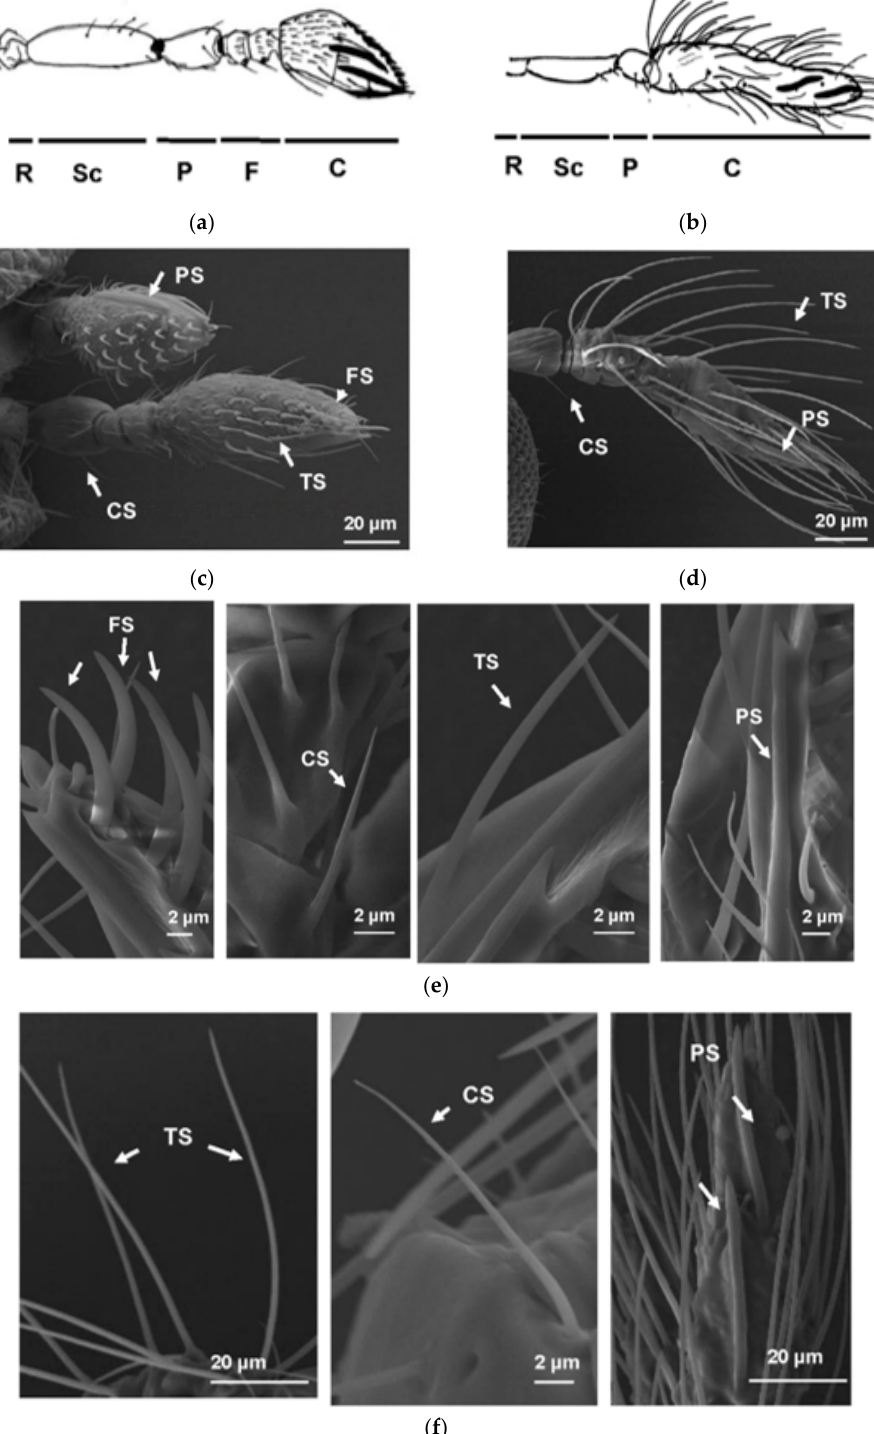
Figure 1. The scanning electron microscopy (SEM) analysis of T. pretiuosum female and male antennae and sensilla. ( a , b ) the hand drawings of T. pretiuosum female and male antennae. ( c , d ), SEM analysis of T. pretiuosum female and male antennae. ( e , f ), SEM analysis of T. pretiuosum female and male olfactory sensilla on the antennae. Sc, elongated scape; R, basal radicle; P, pedicel; F, flagellum; and C, apical club. Various types of olfactory sensilla were observed, including chaetica sensilla (CS), trichoid sensilla (TS), Placoid sensilla (PS) and faleate sensilla (FS).